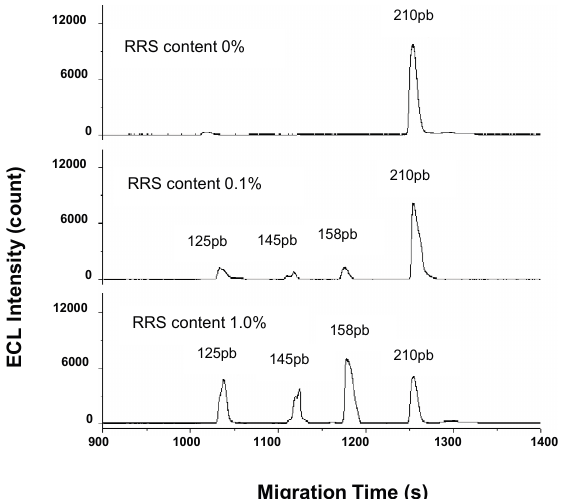
Figure 1. Electrophoregrams obtained by CE-electrochemoluminiscence (ECL) after multiplex PCR for roundup ready soybeans (RRS) certified reference material standards containing 0%, 0.1% and 1.0% of RRS. Reprinted with permission from